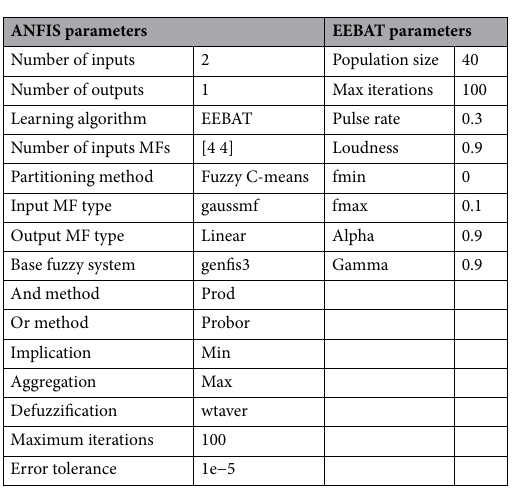
Table 6. ANFIS and EEBAT parameters.